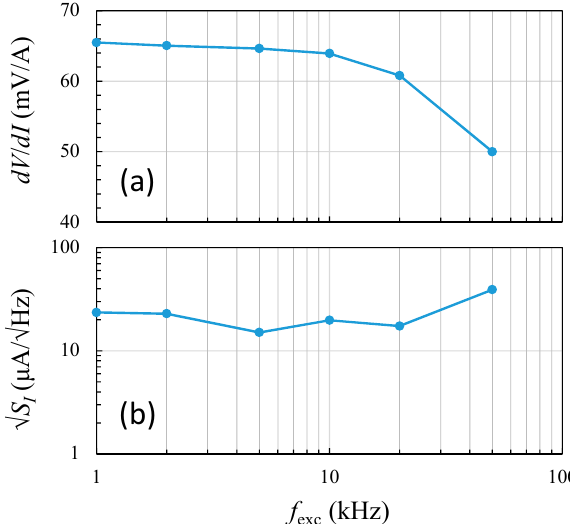
Figure 7. Dependence of the modulation frequency on ( a ) the maximum sensitivity and ( b ) 1-Hz current noise.